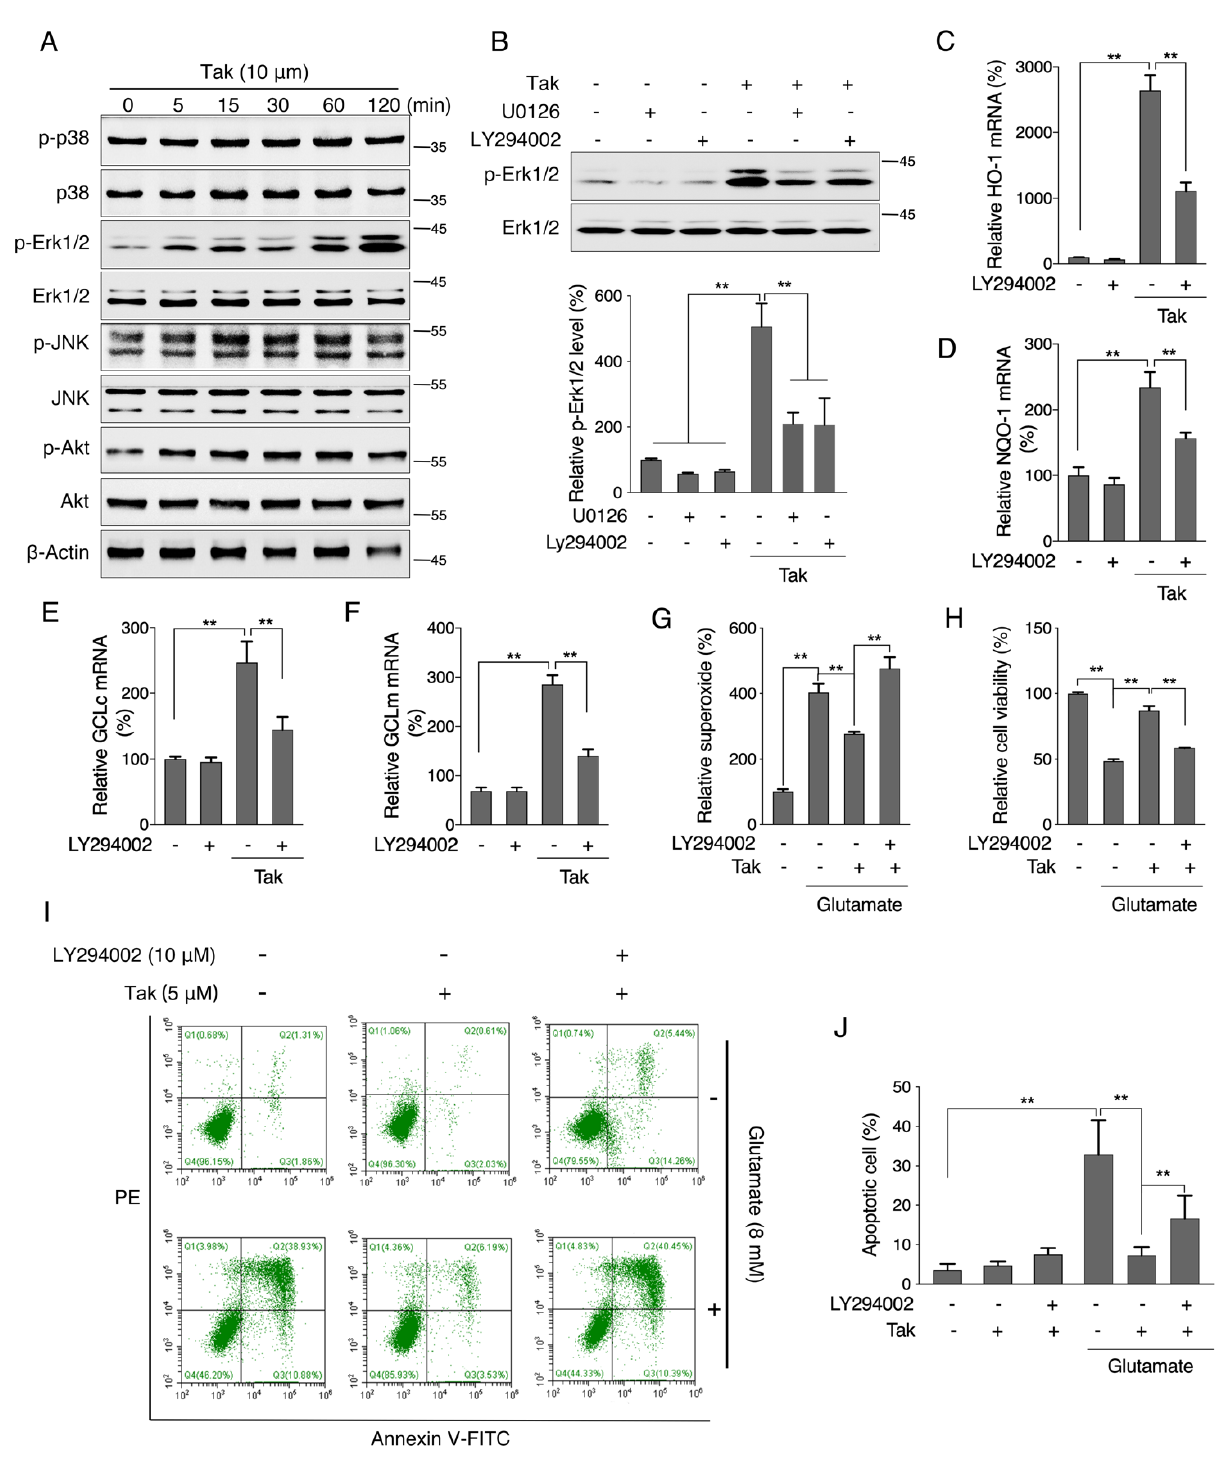
Figure 5. Tak activates phase II enzymes through Akt signaling. ( A ) HT22 cells were treated with 10 μM Tak for 0, 5, 15, 30, 60, and 120 min, and kinase activation was analyzed by western blot. ( B ) HT22 cells were treated with Tak for 30 min with or without LY294002 and U0126, and p-Erk1/2 was analyzed by western blot. HT22 cells were treated with 5 μM Tak for 6 h with or without LY294002, and the mRNA expression levels of HO-1 ( C ), NQO-1 ( D ), GCLc ( E ), and GCLm ( F ) were analyzed by qRT-PCR. HT22 cells were treated with 5 μM Tak for 24 h with or without LY294002, followed by glutamate treatment for 12 h, mitochondrial superoxide ( G ), cell viability ( H ), and cell apoptosis (( I ): flow cytometry images; ( J ): statistical analysis) were analyzed. The values are presented as the mean ± S.E.M. from at least three independent experiments. * p < 0.05 and ** p < 0.01 between the connected groups.